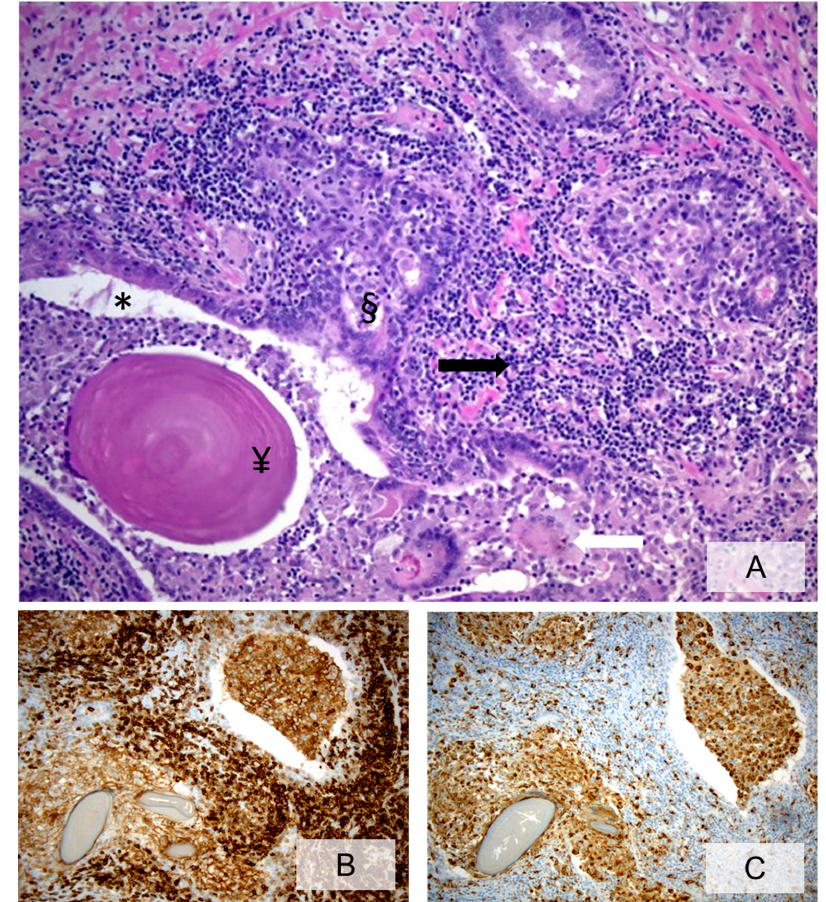
Figure 2. Heavy chronic inflammation with confluent areas surrounding prostatic glands, damaging glandular epithelium and involving glandular lumina. Inflammatory cells are represented by lymphocytes, histiocytes and scattered foreign-body-like giant cells ( A , H&E, × 20, black arrow = confluent areas of chronic inflammatory infiltrate mainly consisting of lymphocytes; white arrow = foreign-body-like giant cells; * = prostatic glandular lumina; § = glandular epithelium; ¥ = corpora amylacea within glandular lumina). Immunohistochemical staining with anti-CD45 ( B , × 20) and anti-CD68-PGM1 ( C , ×20) highlights the lymphocyte and the histiocyte components, respectively.